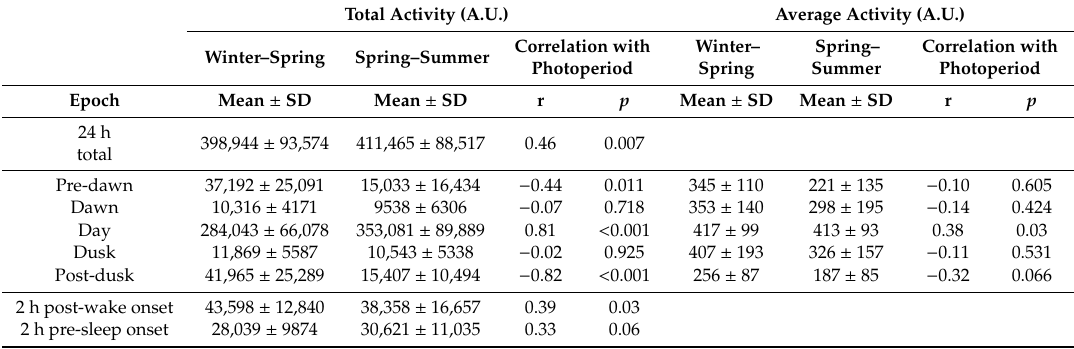
Table 1. Activity measures under short and long photoperiods. Shows total and average activity counts (mean ± SD) for each analysis epoch tested under winter / spring (short) and spring / summer (long) photoperiods. Correlation r and p values reflect results of Pearson’s correlation for relationship between di ff erence in photoperiod duration (long / short) and activity measures. Analysis epochs are: 24 h total (total daily counts for each individual), pre-dawn (total daily counts from wake onset to civil sunrise), dawn (daily counts from civil to actual sunrise), day (daily counts from actual sunrise to actual sunset), Post-dusk (daily counts from civil sunset to sleep onset), 2 h post-wake onset and 2 h pre-sleep onset (daily counts for first hours post-wake onset and last hours pre-sleep onset). Data for average counts are shown only for those epochs whose duration varies depending on individual and / or photoperiod. Total Activity (A.U.) Average Activity (A.U.) Correlation with Winter– Spring– Correlation with Winter–Spring Spring–Summer Photoperiod Spring Summer